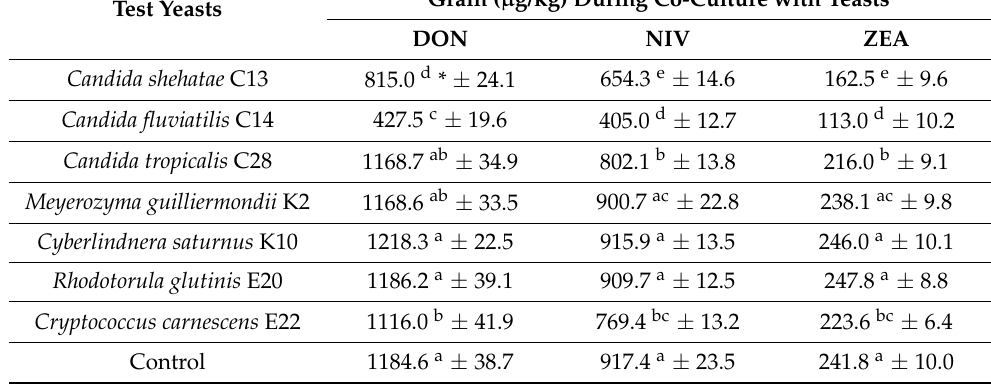
Table 1. Mycotoxin contents in wheat grain after 14 days of incubation (28 ◦ C) of F. culmorum with the test yeasts.